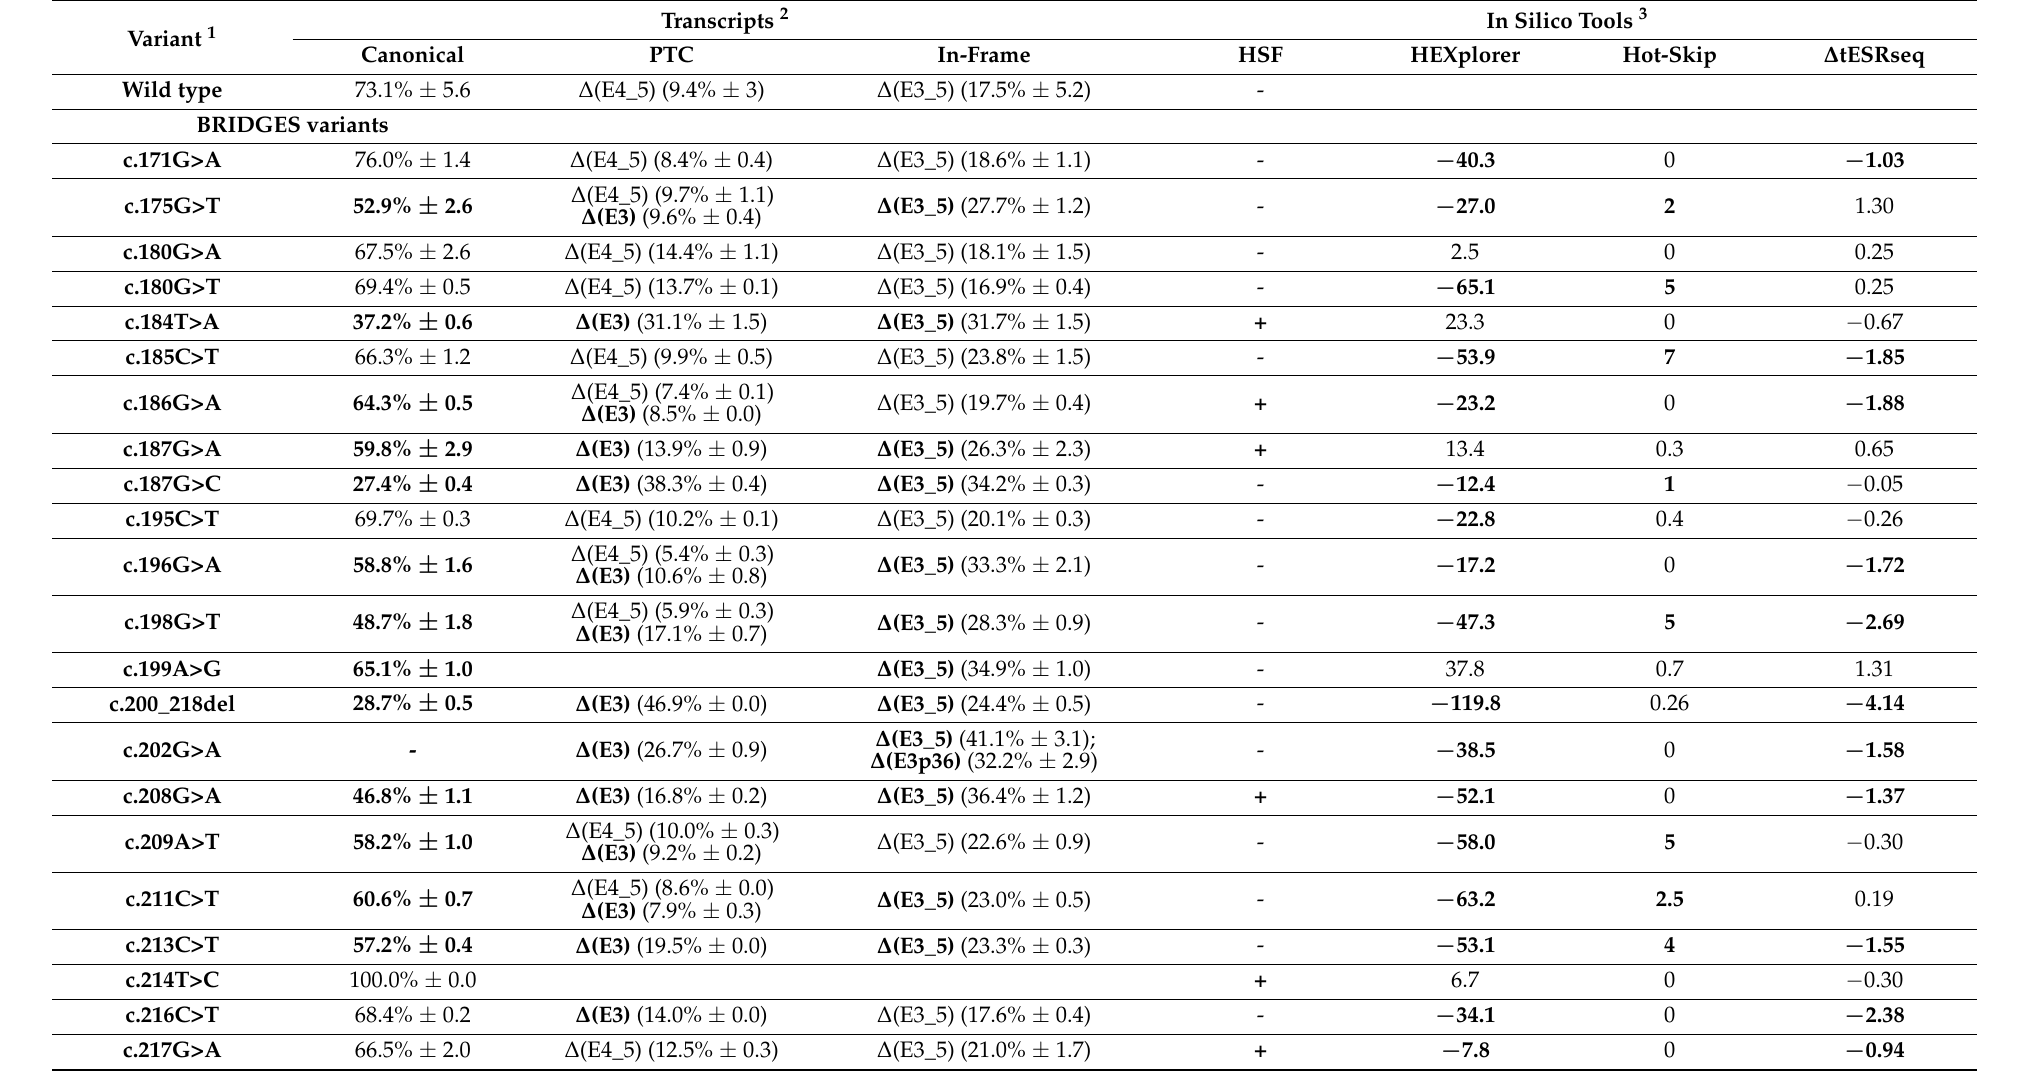
Table 2. Bioinformatics analysis and splicing outcomes of putative exon 3 ESE